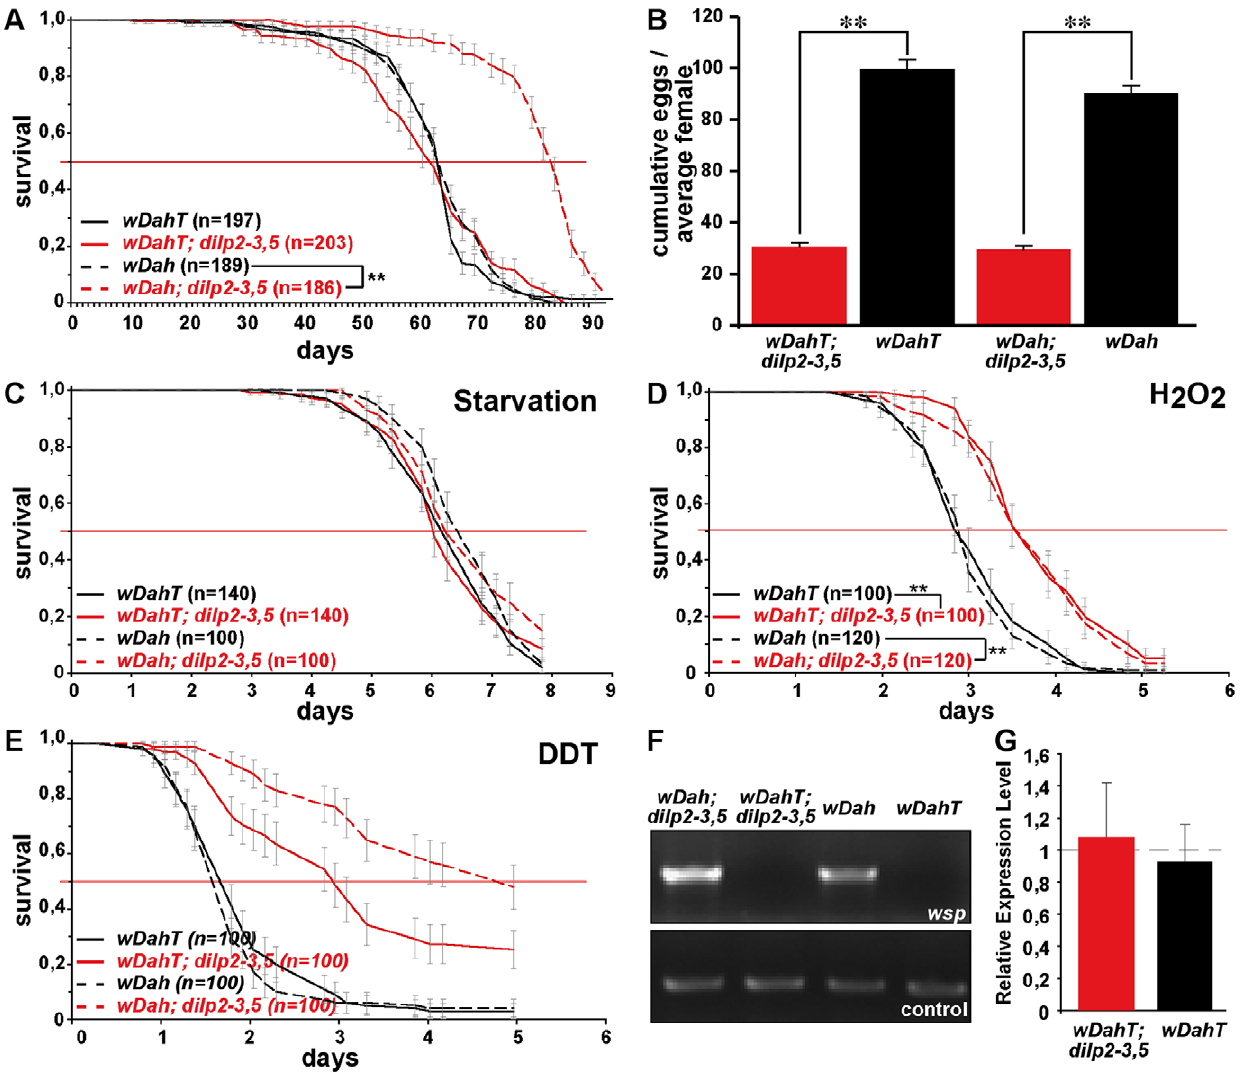
Figure 6. Wolbachia -dependent lifespan extension of dilp2–3,5 mutants is correlated with xenobiotic resistance. Wolbachia affects longevity (A) and xenobiotic resistance (E) of dilp2–3,5 mutants, but not fecundity (B), starvation (C) or oxidative stress resistance (D). (A) Median and maximum lifespan of w Dah ;dilp2–3,5 females (83/92,5 days) compared to w Dah (64,5/76 days) control females is increased by 29% and 22%, respectively. ** p , 0.001, log rank test. In contrast, w DahT ;dilp2–3,5 (62,5/81 days) only show a small increase in maximum, but not in median lifespan compared to w DahT (64,5/74 days) females. (B) Index of lifetime fecundity of dilp2–3,5 females is reduced to 30% but not affected by Wolbachia infection. Shown is the cumulative number of eggs laid by an average female. ** p , 0.01, Wilcoxon rank sum test. (C–E) Survival of dilp2–3,5 females with and without Wolbachia on (C) 1,5% agarose, (D) 5% hydrogen peroxide and (E) DDT (275 mg/l). ** p , 0.01, log rank test. (F) PCR analysis confirms the presence of Wolbachia in w Dah flies and the absence in Tetracycline-treated w DahT flies. (G) Q-RT-PCR analysis shows that 4E-BP expression is not affected by Wolbachia -infection status. 4E-BP transcript level in Wolbachia - flies was normalised to the corresponding Wolbachia + sample, which by default was set to